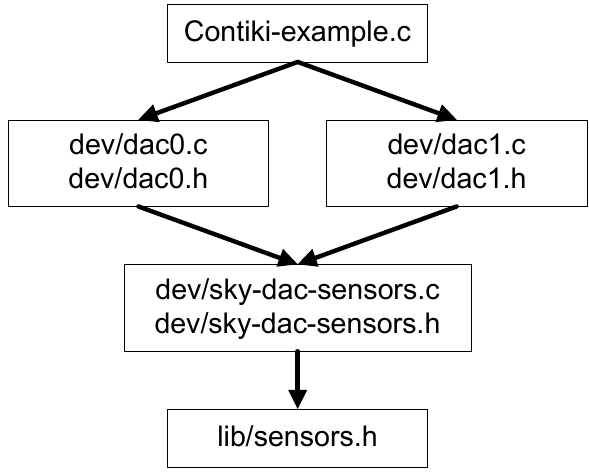
Figure 6. An illustrative example of the Sky DAC drive